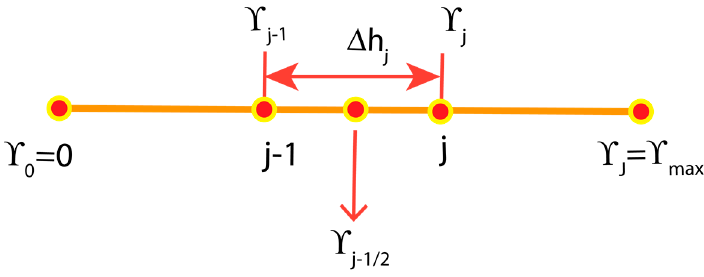
Figure 3. Typical grid structure for difference approximations.